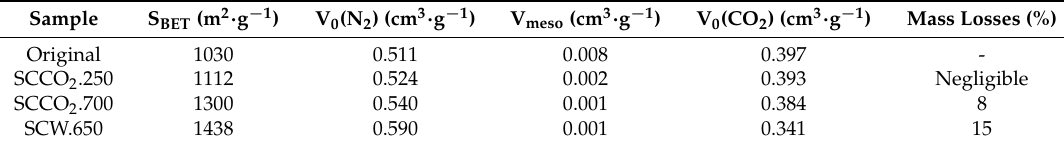
Table 1. Changes in the textural properties of the original activated carbon fiber (ACF) when it is exposed to supercritical